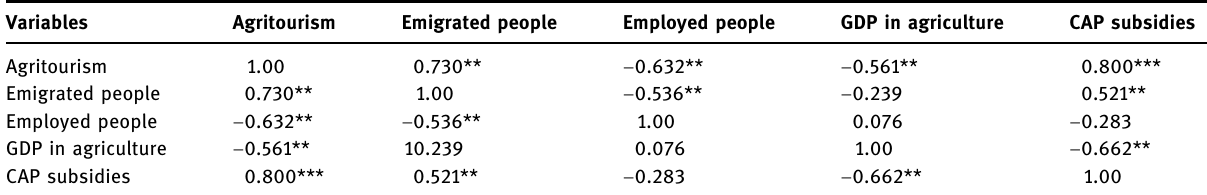
Table 2: Main correlations in some socio - economic variables, agritourism in Romania and fi nancial subsidies allocated by the CAP since 2000 – 2016 ( source: author ’ s own elaboration on data available at http://statistici.insse.ro and https://ec.europa.eu/agriculture/rica/